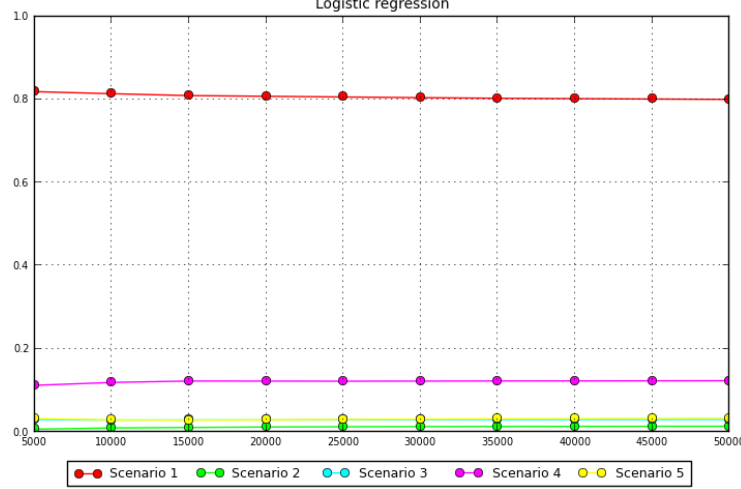
Figure 4. Graph of the posterior probabilities of each scenario estimated using a logistic regression approach.